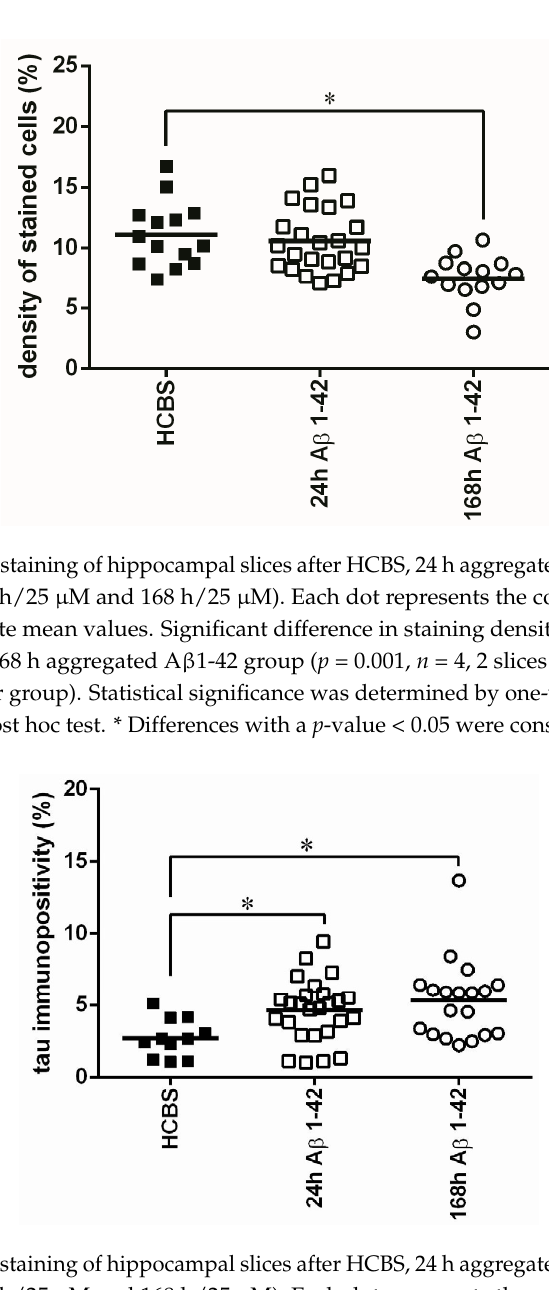
Figure 4. Tau-immunostaining of hippocampal slices after HCBS, 24 h aggregated and 168 h aggregated A β 1-42 treatment (24 h/25 µ M and 168 h/25 µ M). Each dot represents the counted raw data, while horizontal bars indicate mean values. Significant difference in the number of tau-immunopositive cells were observed between HCBS vs. 24 h A β 1-42 treated group and HCBS vs. 168 h A β 1-42 treated group, ( p = 0.042 and p = 0.007 respectively. n = 4, 4 slices/animal; n refers to the number of animals per group). Statistical significance was determined by one-way ANOVA, followed by Hochberg’s GT2 post hoc test. * Differences with a p -value < 0.05 were considered significant.